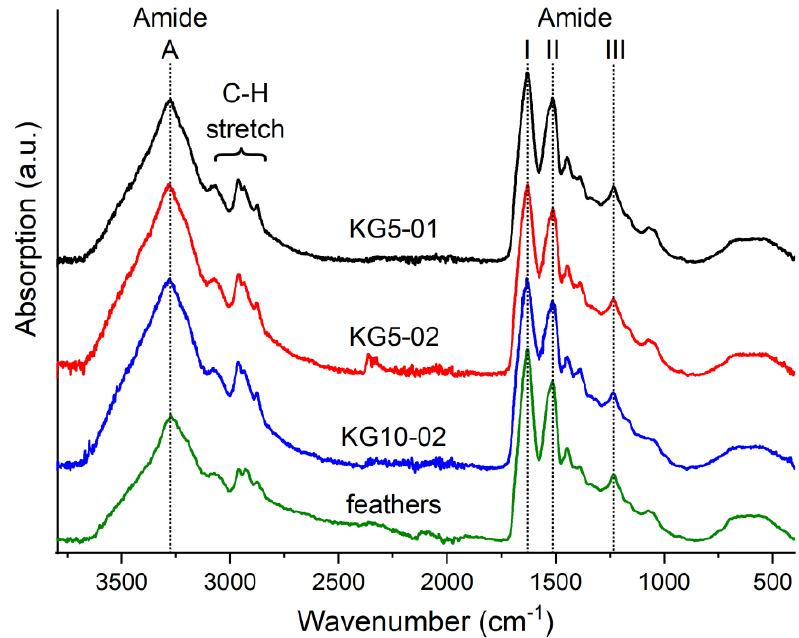
Figure 3. ATR-FTIR spectra of dry keratin hydrogels and raw feathers.